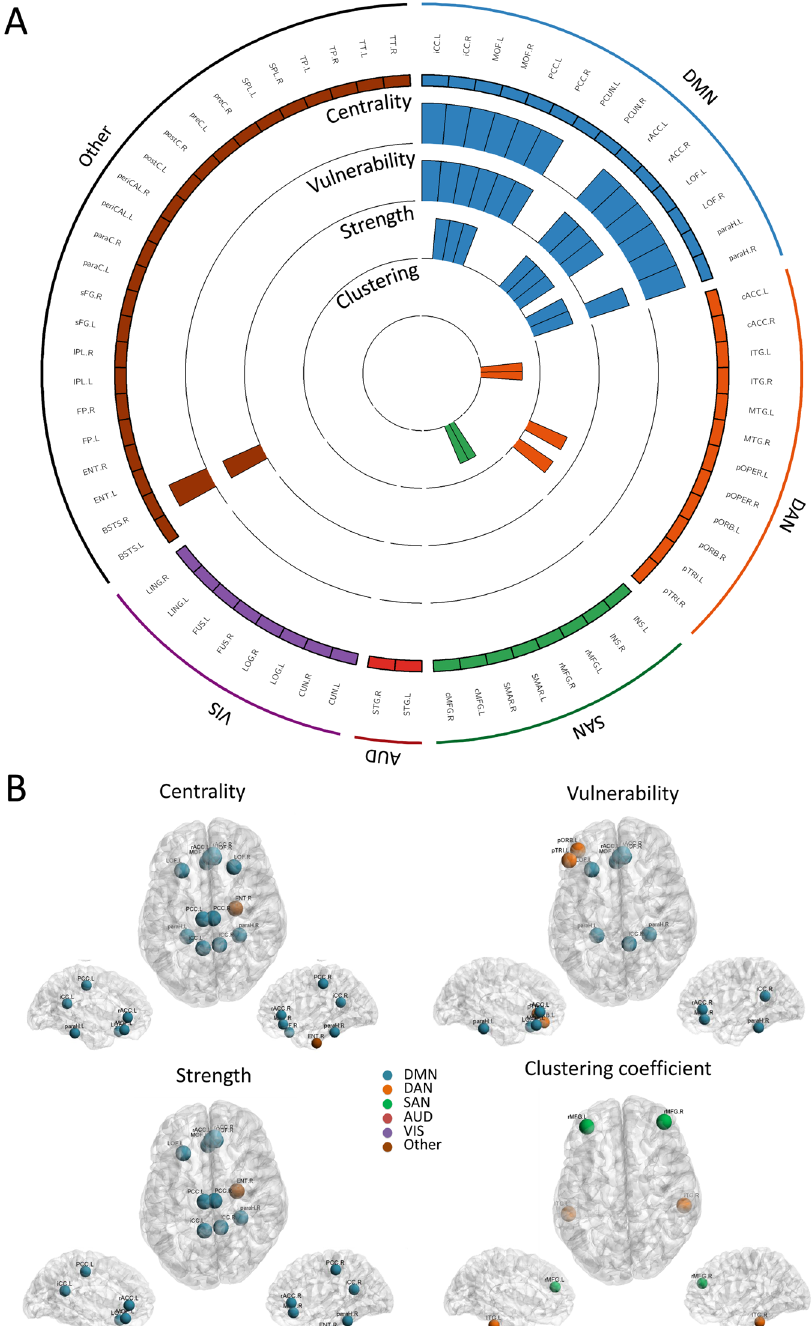
Figure 2. Static analysis: graph metrics. ( A ) The distribution of the four measures across the 68 brain regions. The circular barplots reflect from the outside inward: centrality, vulnerability, strength and clustering coefficient. The outermost ring shows the 68 brain regions obtained from the anatomical parcellation based on Desikan-Killiany atlas 61 , arranged by their assigned resting state networks: default mode network (DMN), dorsal attentional network (DAN), salience network (SAN), auditory network (AUD), visual network (VIS), see Table S1 in Supplementary Materials for more details about these assignments. We only showed the bars for significant nodes ( p < 0.01, Bonferroni corrected). ( B ) The location of the significant brain regions on the cortical surface. The color of the node corresponds to which RSN is assigned. Names and abbreviations of the brain regions are listed in Table